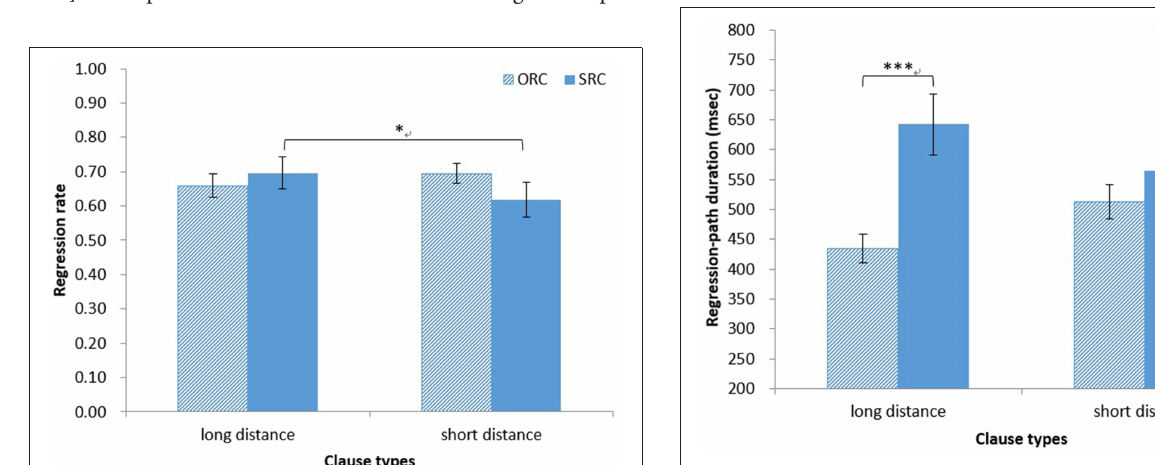
FIGURE 4 | Chinese group: regression rate for EVs in RCs. * p < 0.05 .